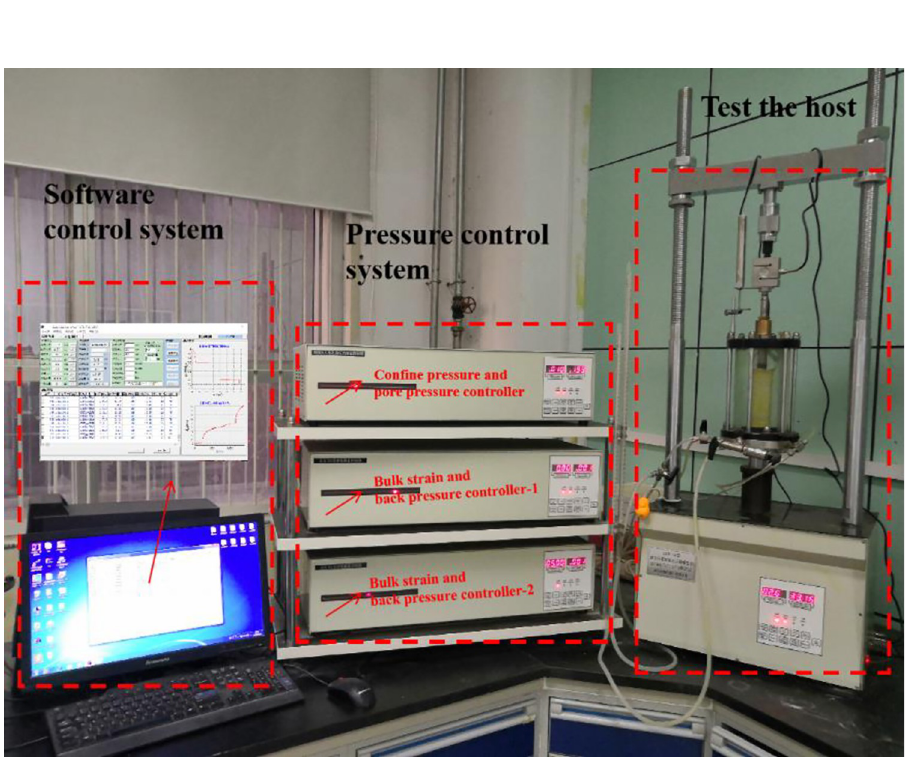
Fig 3. Triaxial creep shear apparatus on SLB-1A stress-strain controlled test